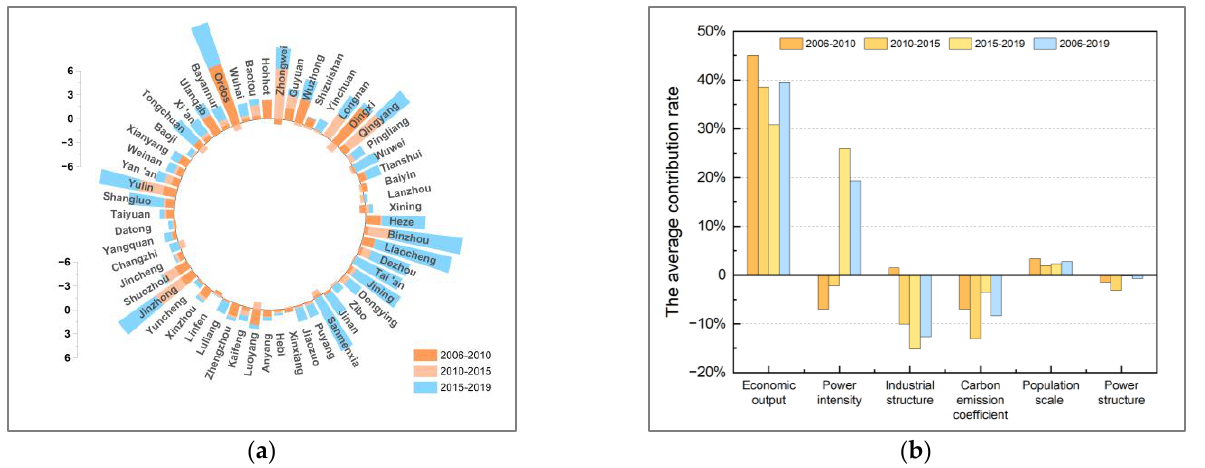
Figure 7. Cumulative contribution value and cumulative contribution rate in 2006 – 2010, 2010 – 2015, and 2015 – 2019. ( a ) Cumulative contribution value (decoupling index). ( b ) Cumulative contribution rate of six factors.